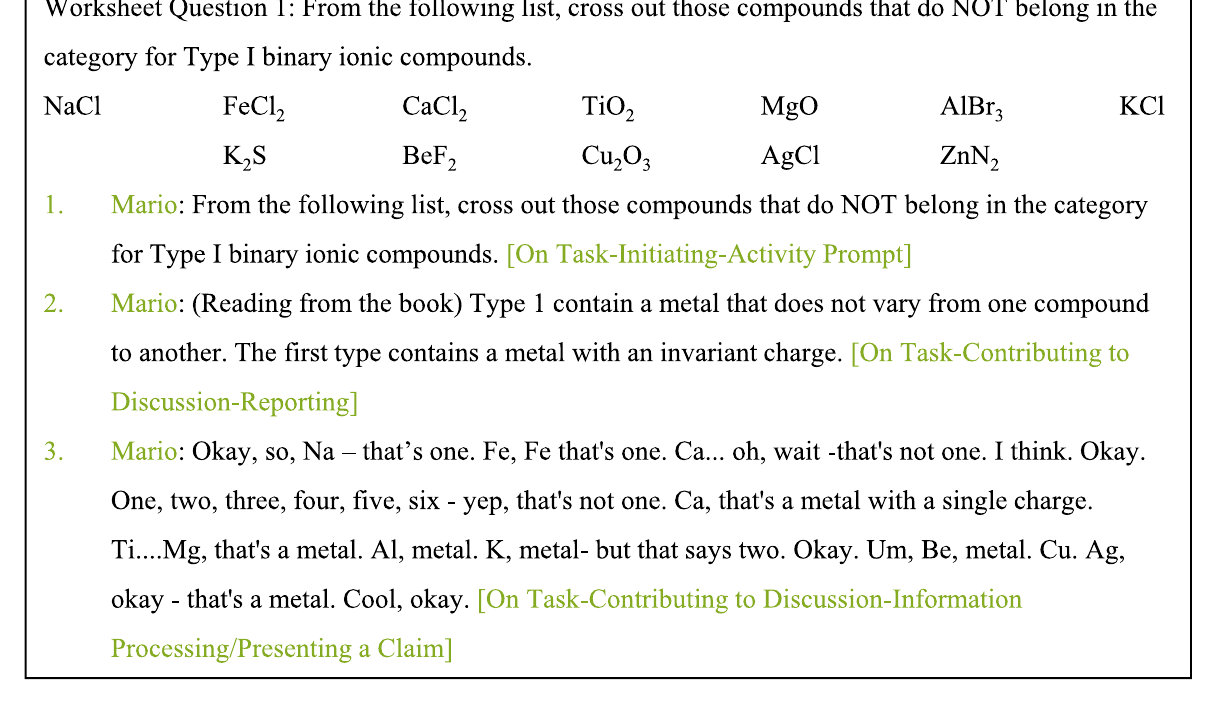
Table 5 Example Coded Excerpt. Coded excerpt transcript of Mario’s contributions as they worked through a worksheet prompt with Luigi (who does not contribute during this segment). Codes are written in the format as [Type of Interaction-Primary Intent – Nature of Utterance]